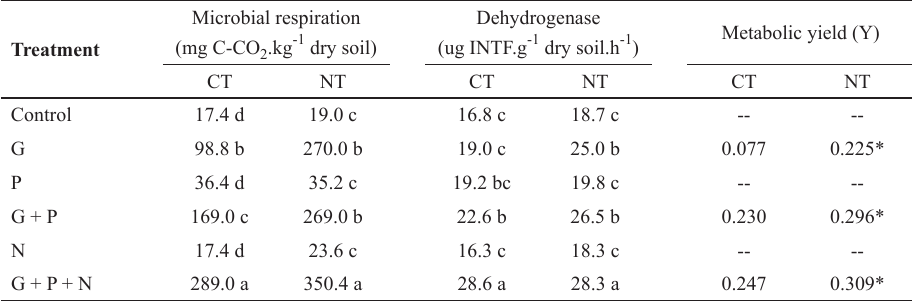
Microbial responses to nutrient addition under conventional tillage (CT) and no-tillage (NT)